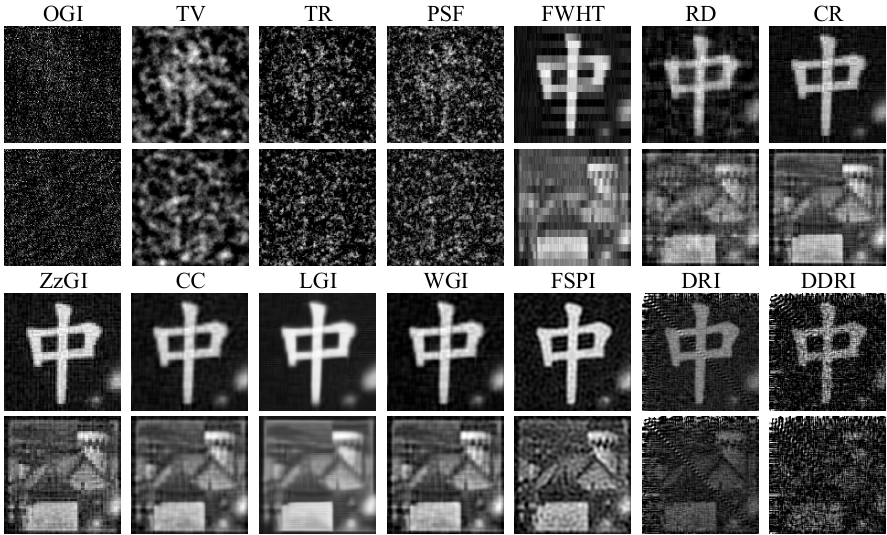
Figure 9. Experimental results of fourteen GI methods in the general environment (without WT). Figure 10. Experimental results of fourteen GI methods in the underwater environment (with WT, without turbulence). Table 7. PSNR and RMSE of images corresponding to the object “ ” in Figure 10.